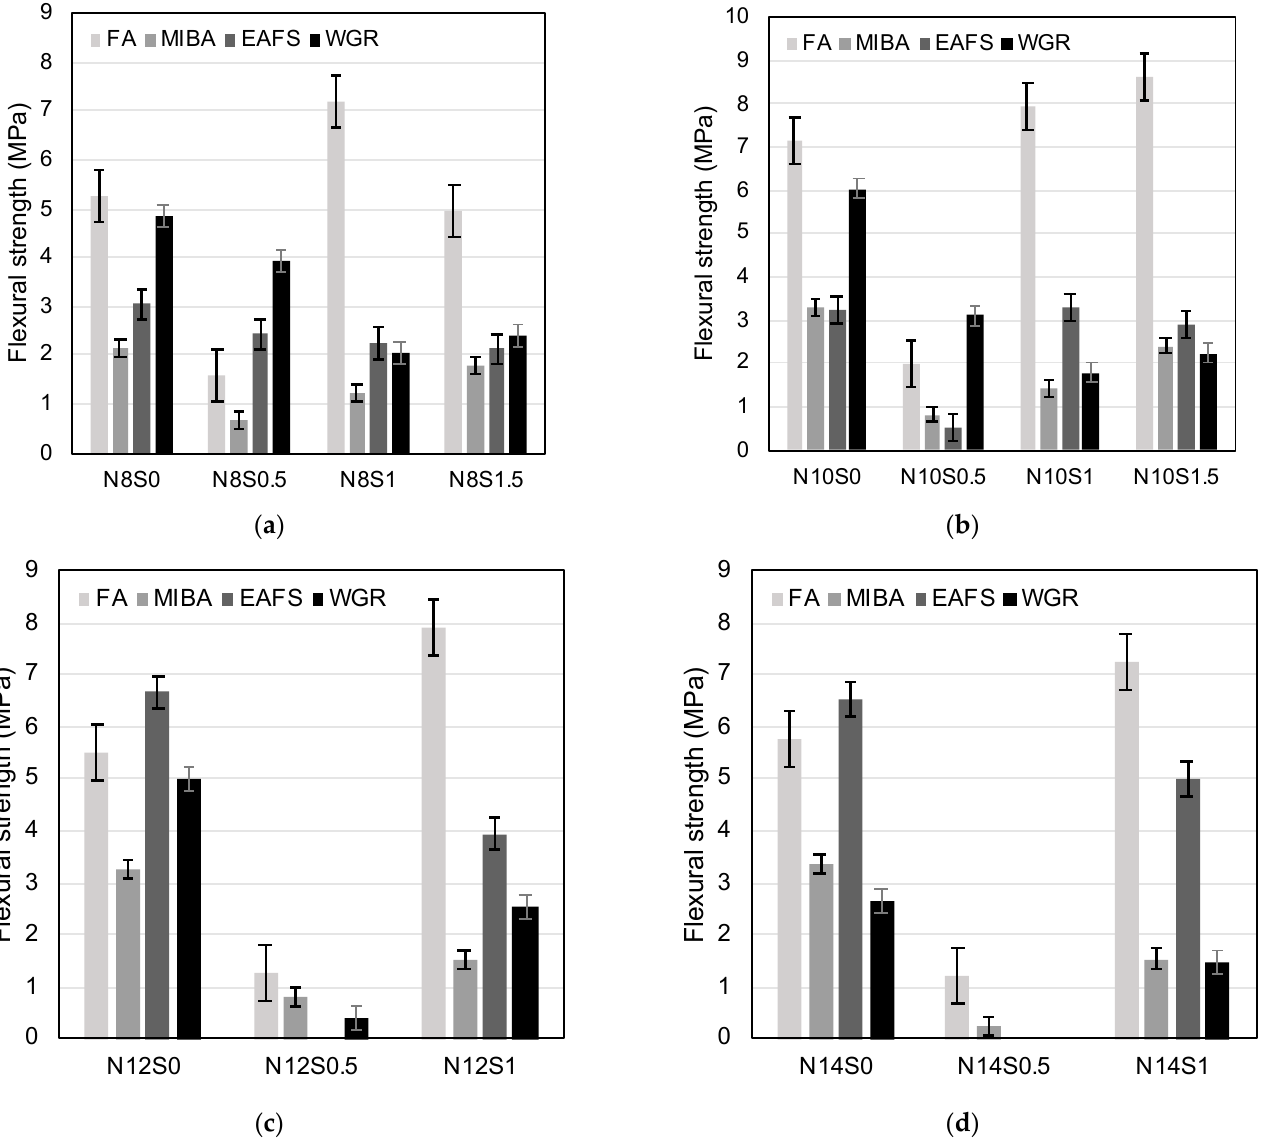
Figure 10 . Flexural strength values for mixes with FA, MIBA, EAFS, and WGR with Na 2 O/binder ratios of ( a ) 8%, ( b ) 10%, ( c ) 12%, and ( d ) 14%, respectively. A correlation between the flexural strength results and the compressive strength ones was established (Figure 11). Based on the trendline, the positive correlation coefficient close to 1 (R 2 ≈ 0.98) indicated that the two variables (flexural ( y -axis) and compressive ( x - axis) strengths) are highly correlated, regardless of the variating ingredients’